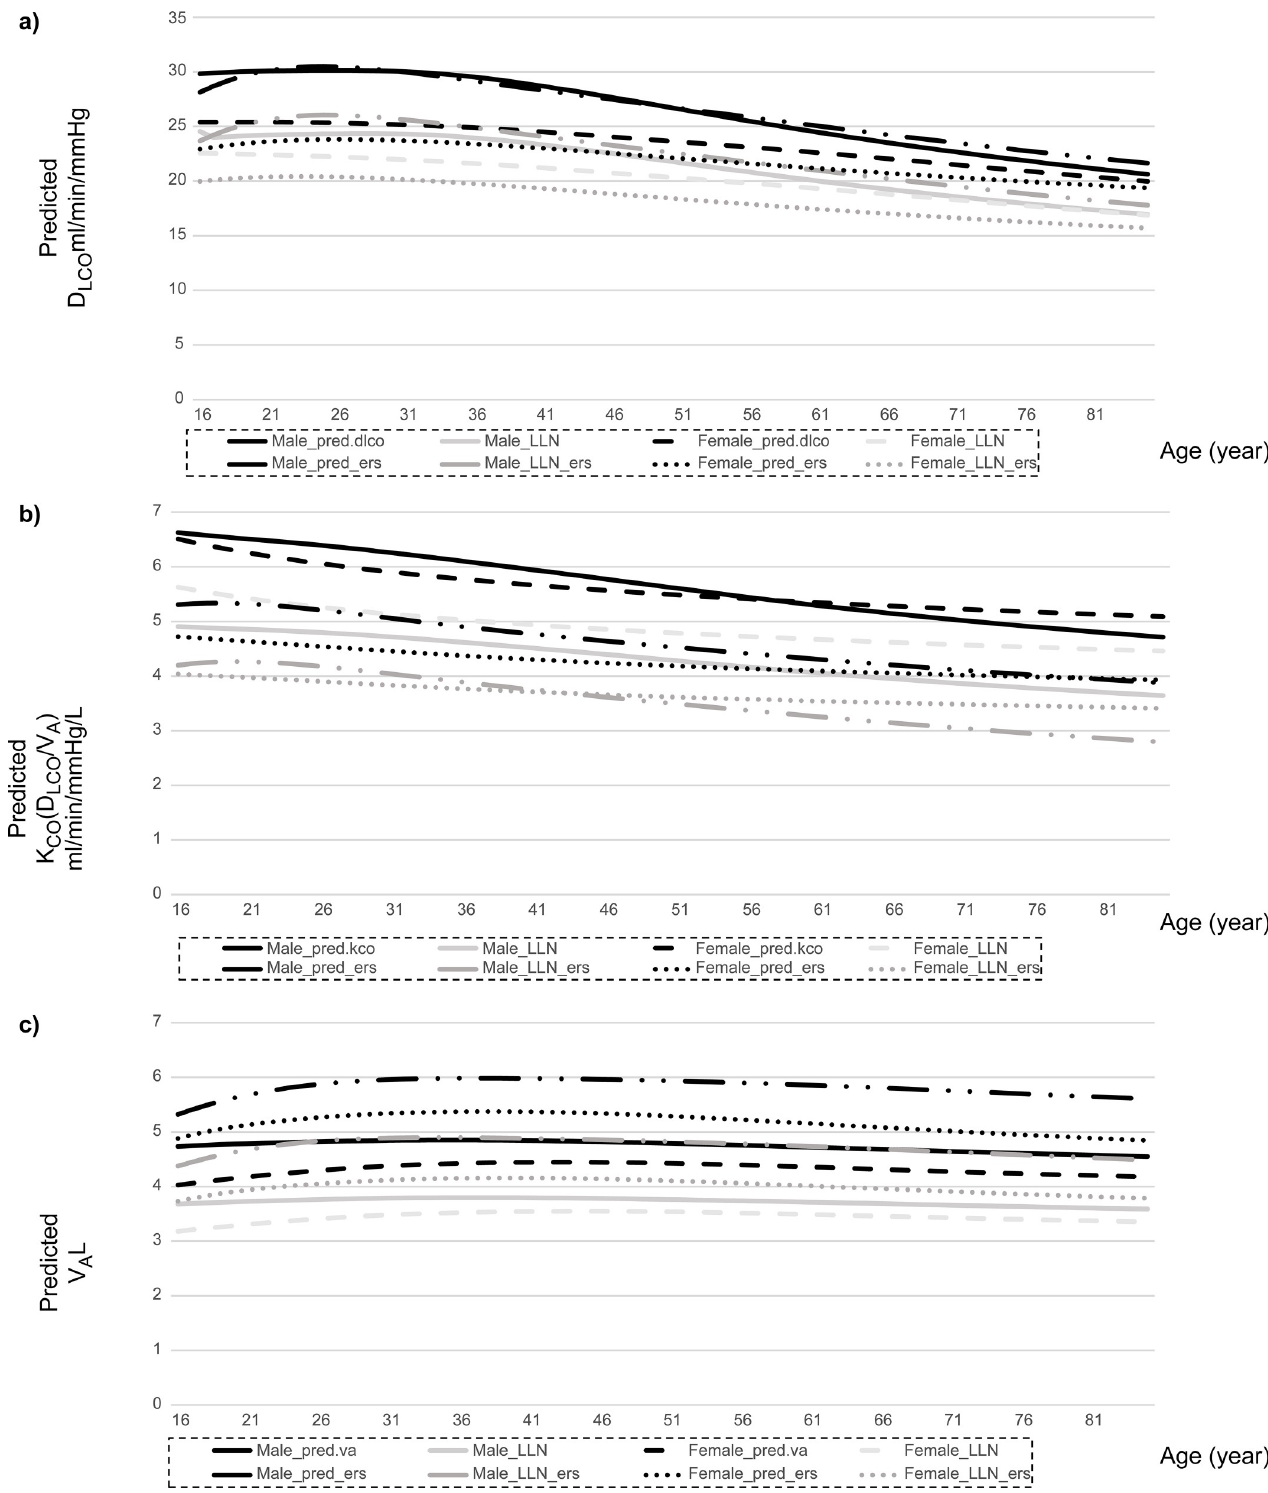
Fig 2. Relationships between the present study values and GLI-2017 predicted values and the lower limits (LLN) of normal in Japanese population (n = 390), with a height of 170 cm and of different ages. Abbreviations: D LCO , single breath diffusing capacity for carbon monoxide; K CO , single breath diffusing capacity for carbon monoxide per unit of lung volume; LLN, lower limits of normal; and V A , alveolar volume.